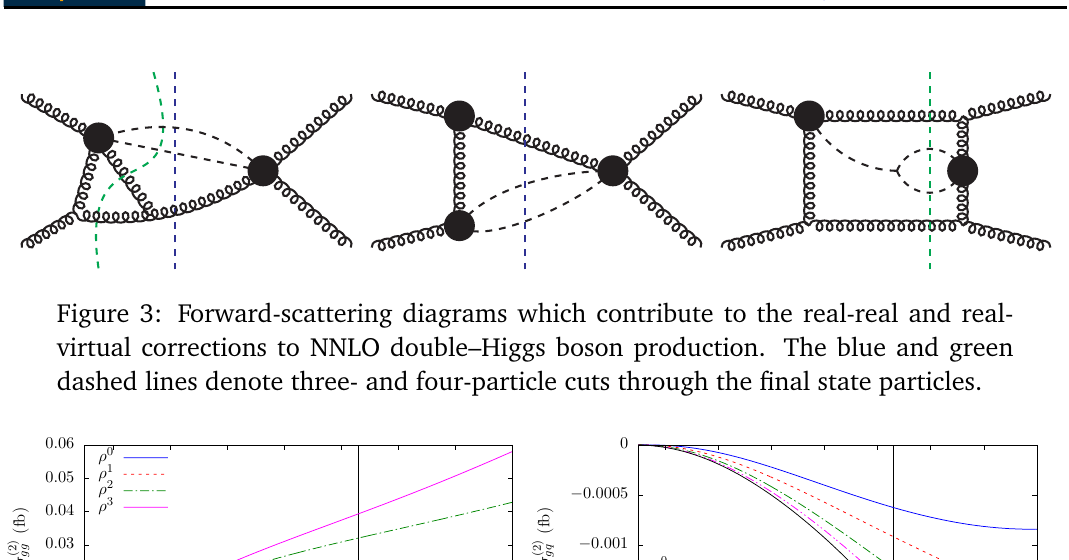
(cid:112) s = 2 m . The curves show different t / m 2 ) n H t